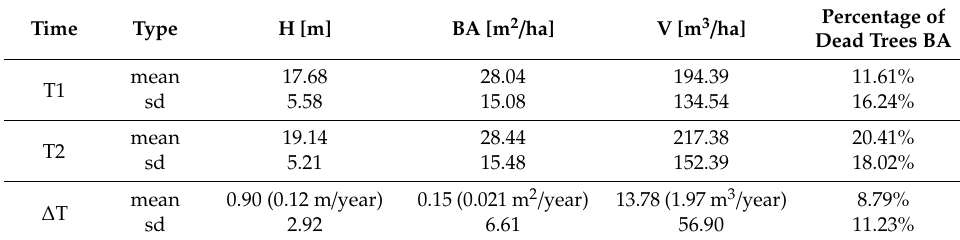
Table 1. Summary of the ground plot data.